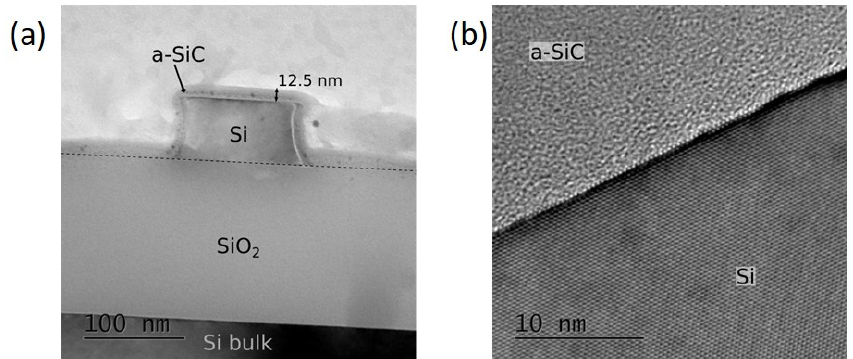
Figure 12. Si/SiC nanowire DNA sensor structure. ( a ) TEM cross-section image of a Si NW etched from SOI substrate and covered with a -SiC deposited by PECVD, and ( b ) HR-TEM image at the Si/ a -SiC interface [43].